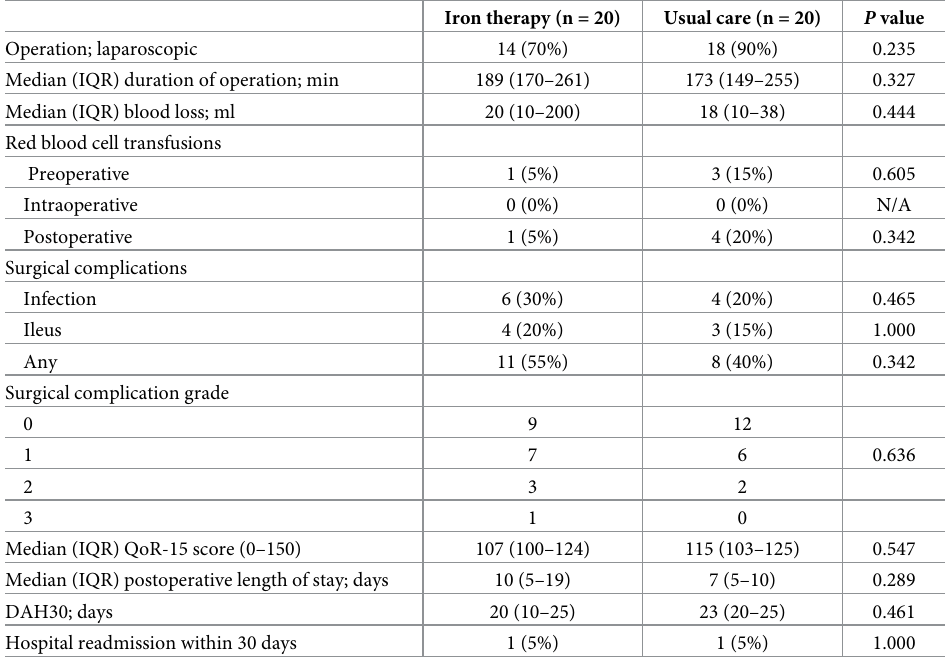
Table 2. Intraoperative and postoperative data in patients receiving iron isomaltoside or usual